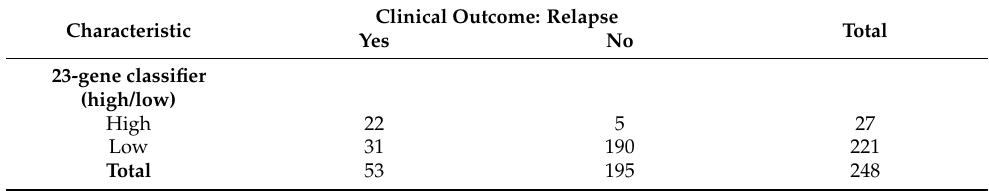
Table 4. Confusion matrix with clinical performance metrics for 23-gene classifier.